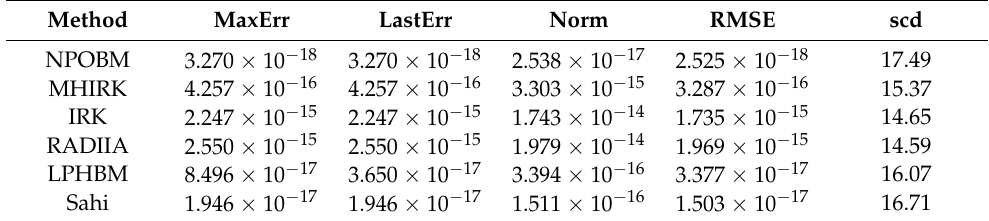
Table 1. Numerical results for Problem 1 with NS = 10 2 , where x ∈ [ 0,2 ] .